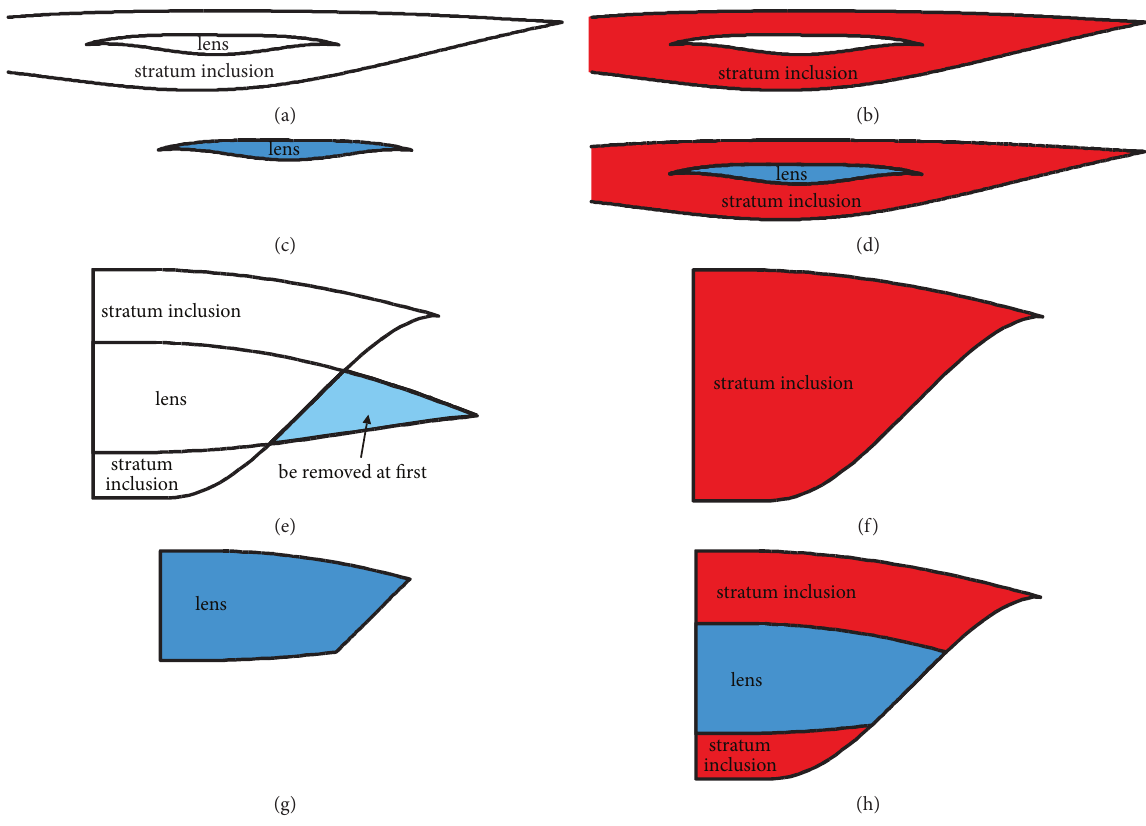
Figure 8: The topo-relationship handling of the stratum inclusion and the interlayer: (a) the initial section lines of the classic lens and the stratum inclusion drawn by the proposed method (case 1), (b) the section lines of the stratum inclusion after topo-relationship handling of case 1, (c) the section lines of the classic lens after topo-relationship handling of case 1, (d) the result section lines after topo-relationship handling of case 1, (e) the initial section lines of the interlayer and the stratum inclusion drawn by the proposed method (case 2), (f) the section lines of the stratum inclusion after topo-relationship handling of case 2, (g) the section lines of the interlayer after topo-relationship handling of case 2, and (h) the result section lines after topo-relationship handling of case